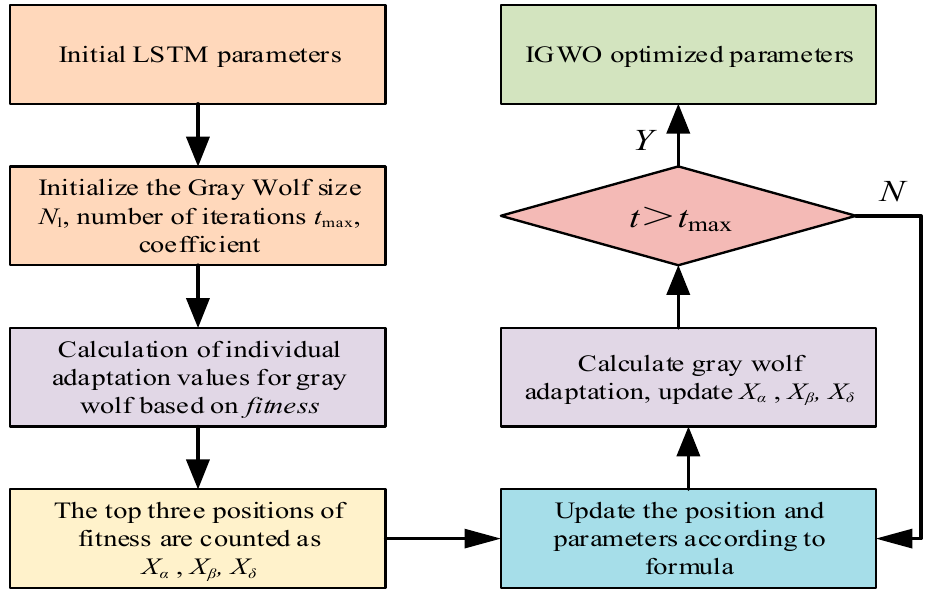
Figure 3. The flowchart of IGWO to optimize the parameters of LSTM model in Figure 3. The fl owchart of IGWO to optimize the parameters of LSTM model in EALL.